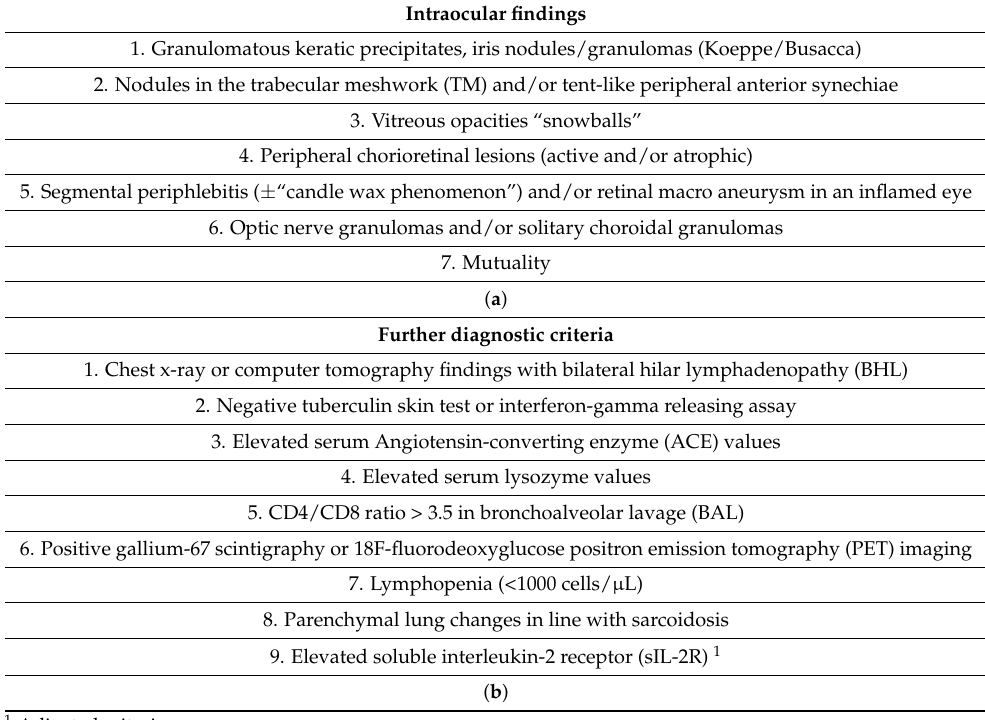
Table 1. International Workshop on Ocular Sarcoidosis criteria (Adapted from [11]). The following key findings are used to determine the diagnosis of ocular sarcoidosis. They are listed as: ( a ) Intraocular findings and ( b ) Further diagnostic criteria.